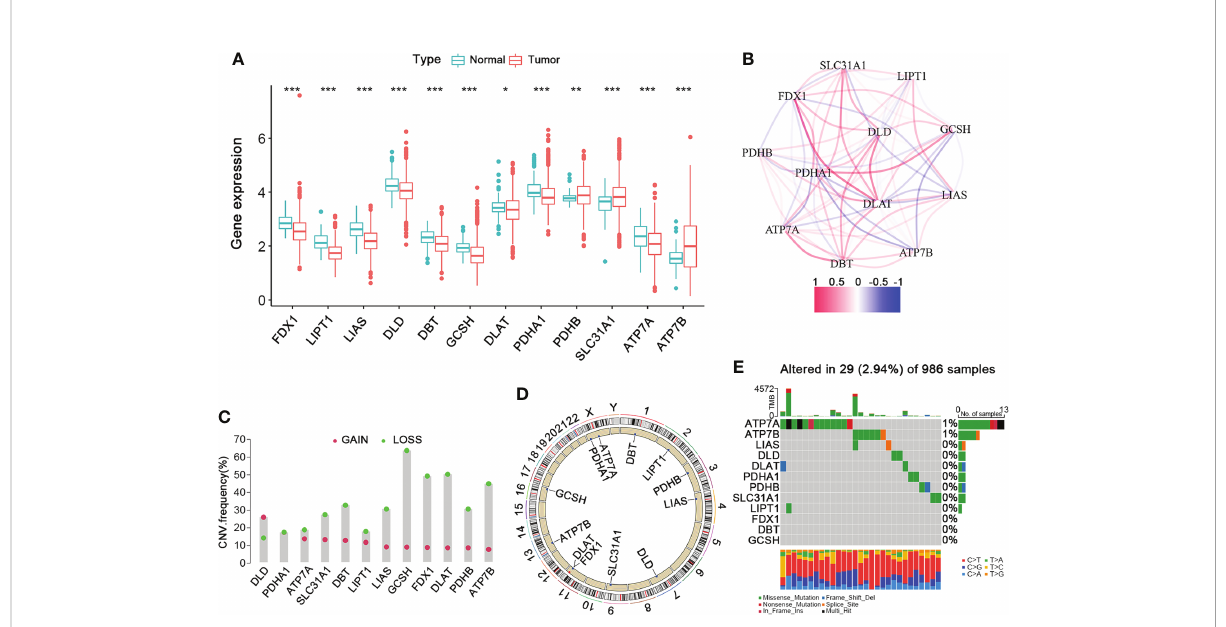
FIGURE 2 The Landscape of Cuproptosis-Related Genes in BRCA. (A) The gene expression levels of CRGs in BRCA compared to normal tissue (Wilcoxon test; blue: normal; red: BRCA). (B) The correlation network of the 12 CRGs (red: positive correlation; blue: negative correlation). (C) The frequency of CNV variation in CRGs (green: CNV deletion; red: CNV ampli fi cation). (D) The location of the CNV alteration of the CRGs changes on 23 chromosomes. (E) The genetic alteration on a query of CRGs. CRGs, cuproptosis-related genes; BRCA, breast cancer; CNV, copy number variant. * p < 0.05, ** p < 0.01, *** p <